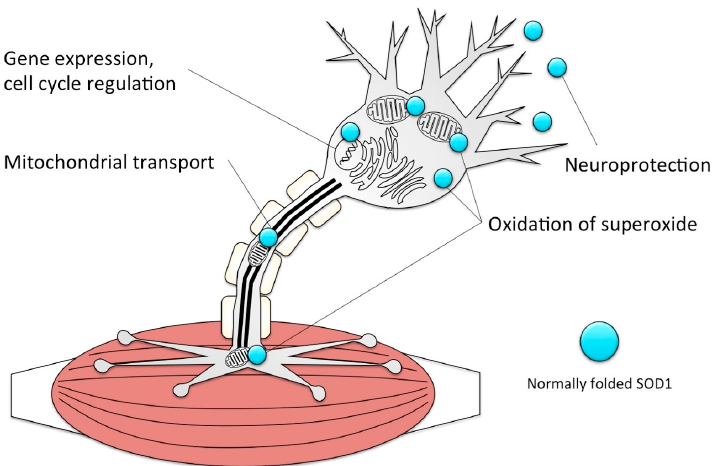
Figure 6. Functions of superoxide dismutase 1 (SOD1) in motoneurons. SOD1 is located in the cytoplasm, synapse and intermembrane space of mitochondria. SOD1’s role is to oxidize free radicals,